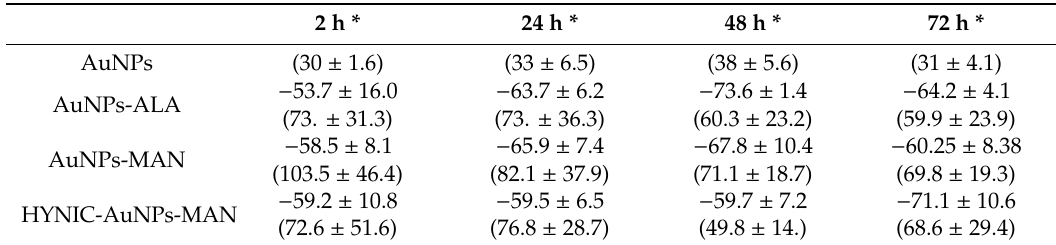
Table 1. Z-potential values and hydrodynamic diameter (in parentheses) for synthesized particles. Values represent the mean value ± SD.